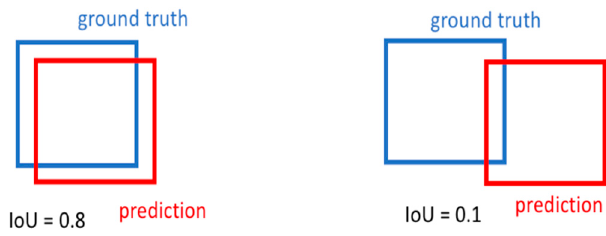
Figure 19. Examples of graffiti detections.